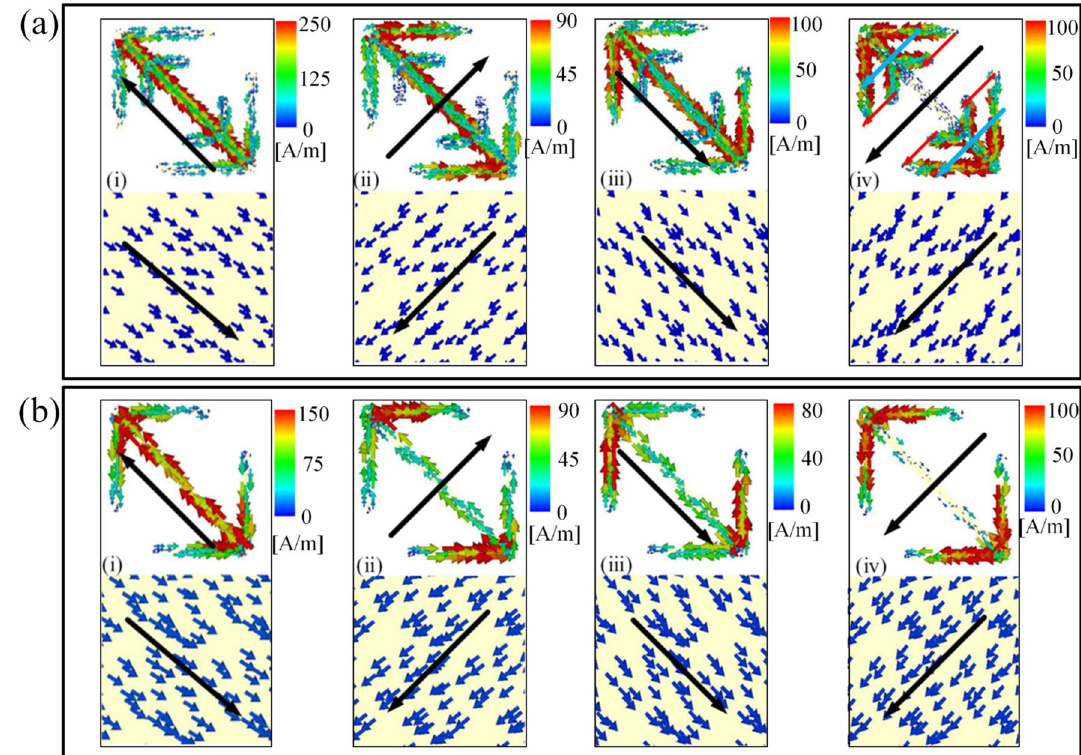
Figure 4. (a) Surface current distributions of unit 2 on the metallic parts of the metasurface unit cell and metallic ground sheet at first four resonance frequencies: (i)3.25 GHz, (ii) 4.81 GHz, (iii) 8.24 GHz, (iv) 11.69 GHz. (b) Surface current distributions of unit 1 on the metallic parts of the metasurface unit cell and metallic ground sheet at four resonance frequencies: (i) 3.08 GHz, (ii) 4.46 GHz, (iii) 7.34 GHz, (iv) 11.07